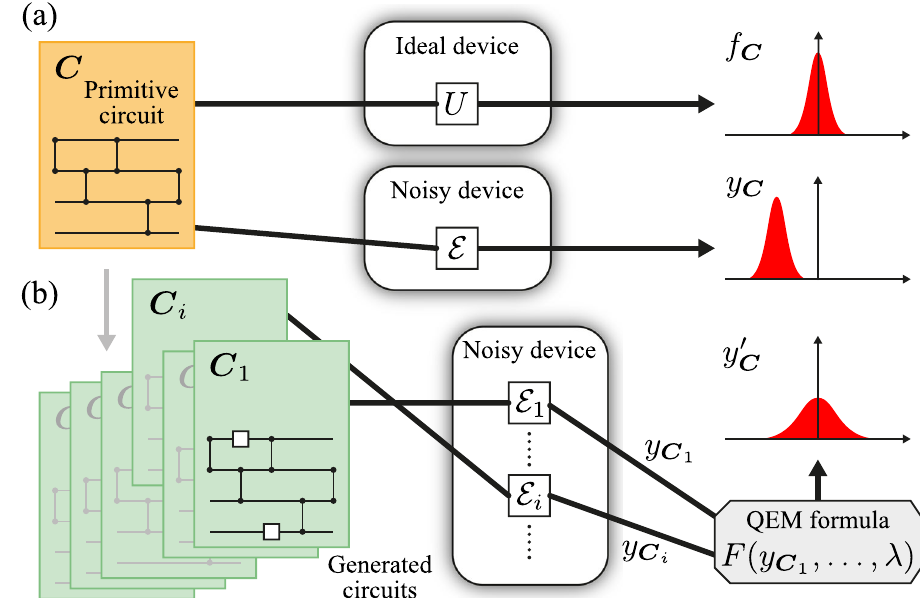
Fig. 1 Schematic illustration of quantum error mitigation formulas. a Ideal and noisy quantum computing for the expected value of an observable. The distribution of the expected value is biased because of noise. b Error-mitigated quantum computing. The bias is corrected in quantum error mitigation